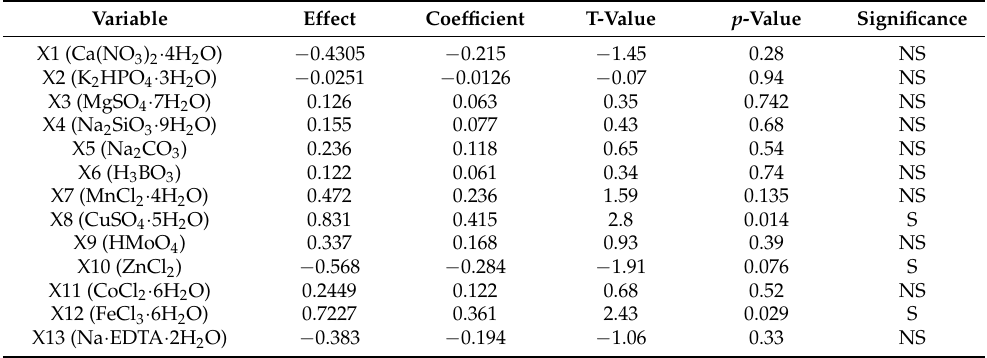
Table 3. Statistical analysis of the results of Plackett–Burman experiment of each variable.